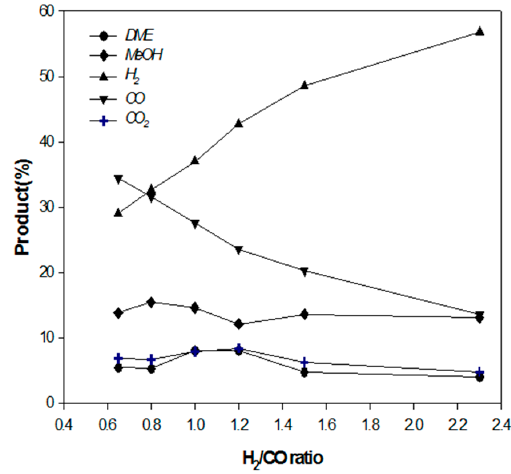
ff ect of H / CO ratio on DME and methanol Figure 14. Effect of H 2 /CO ratio on DME and methanol yields. Figure 14. Effect of H 2 /CO ratio on DME and methanol yields. Figure 14. E 2